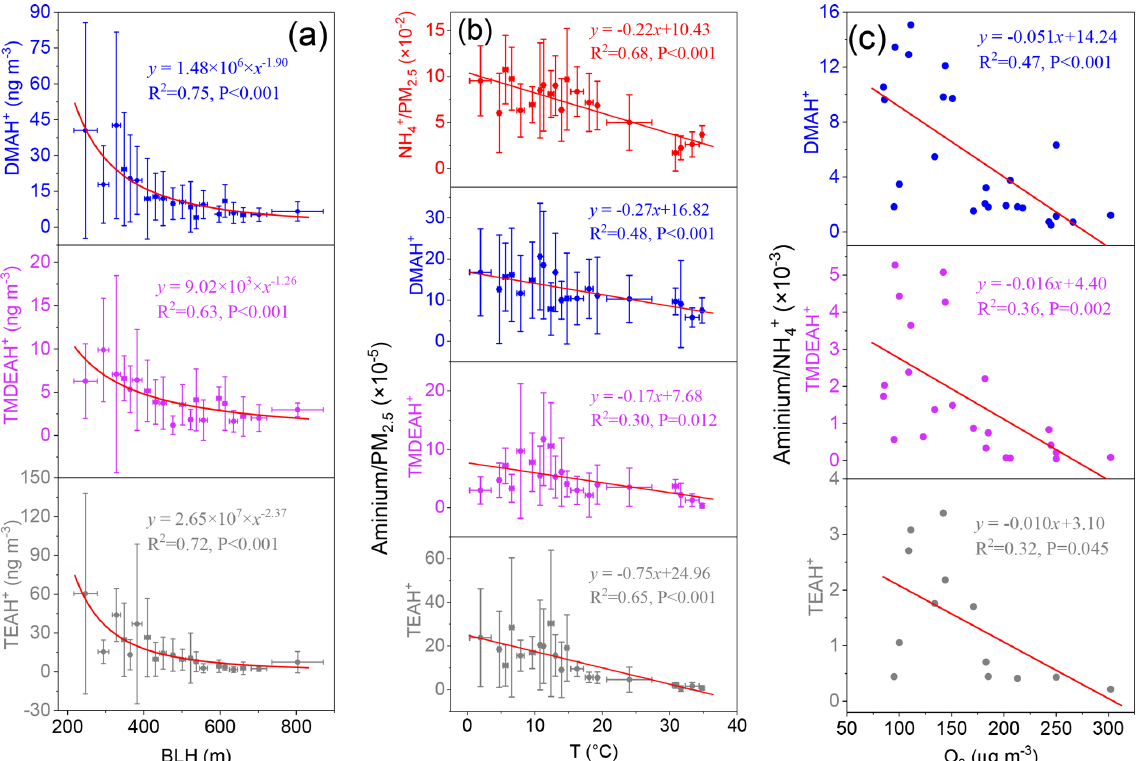
Figure 3. (a) Relationships between concentrations of aminiums and boundary layer height (BLH) over Shanghai in 2013. (b) Relationships between mass ratios of aminiums and NH + to PM 2 . 5 and temperature over Shanghai in 2013. (c) Relationships between mass ratios of 4 aminiums to NH + and O 3 concentrations over Shanghai during the summer of 4